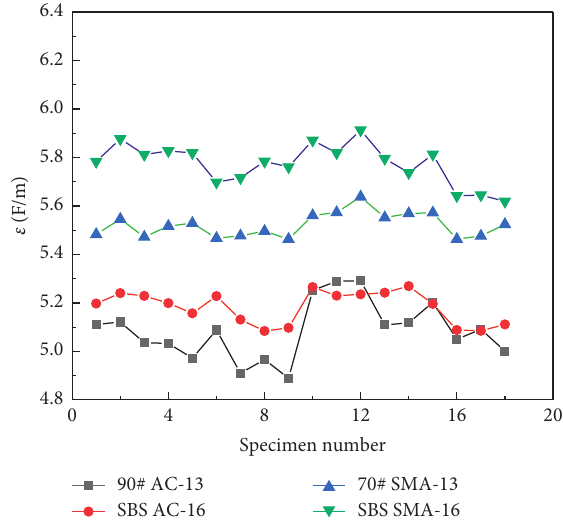
Figure 6: Dielectric constant of the asphalt mixtures at the test frequency of 2.0GHz.